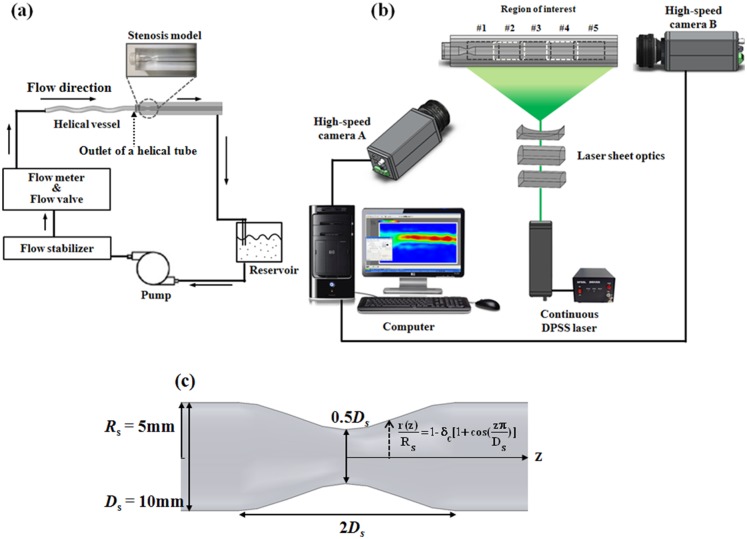
Schematic diagrams of the experimental set-up.(a) Flow circuit system, (b) PIV velocity field measurement system, (c) schematic of the stenosis model.